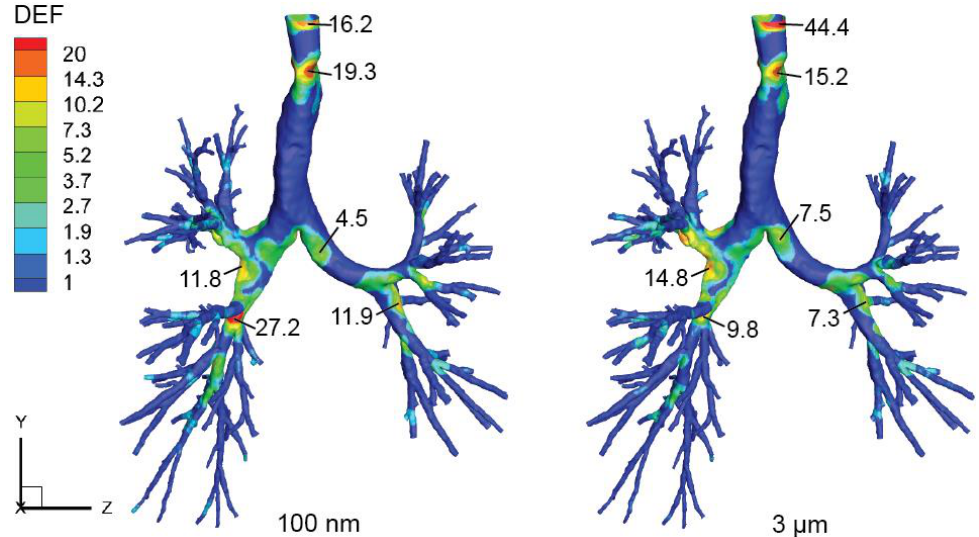
Figure 8. DEF contours of a human lower respiratory airway following exposure of 100 nm and 3 µm particles at flow rate of 18 L/min. Results were reproduced from [40].